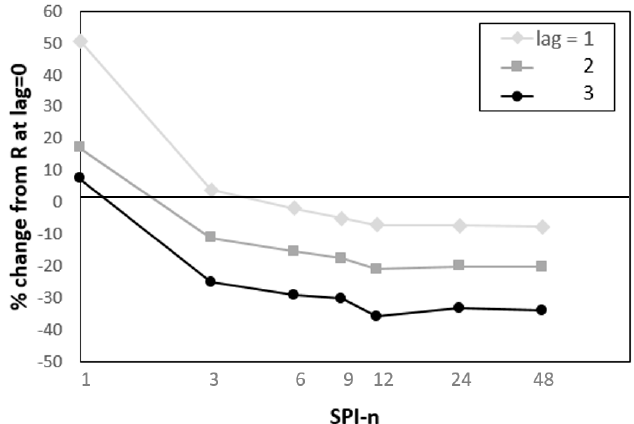
Figure 2. Percentage changes in the global-average R between SPI-n and TWSA for different time lag values compared to the outcome for no lag (as reported in Figure 1).